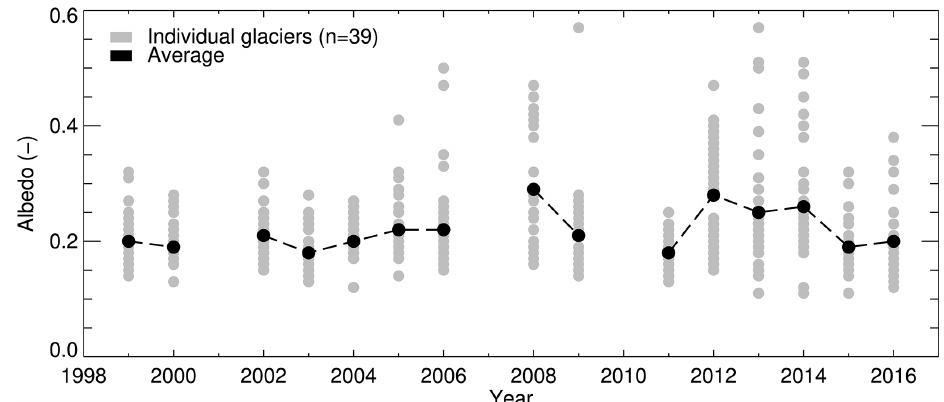
Figure 4. Time series of mean bare-ice albedo of all 39 glaciers (grey dots) and their overall average (black dots with dashed